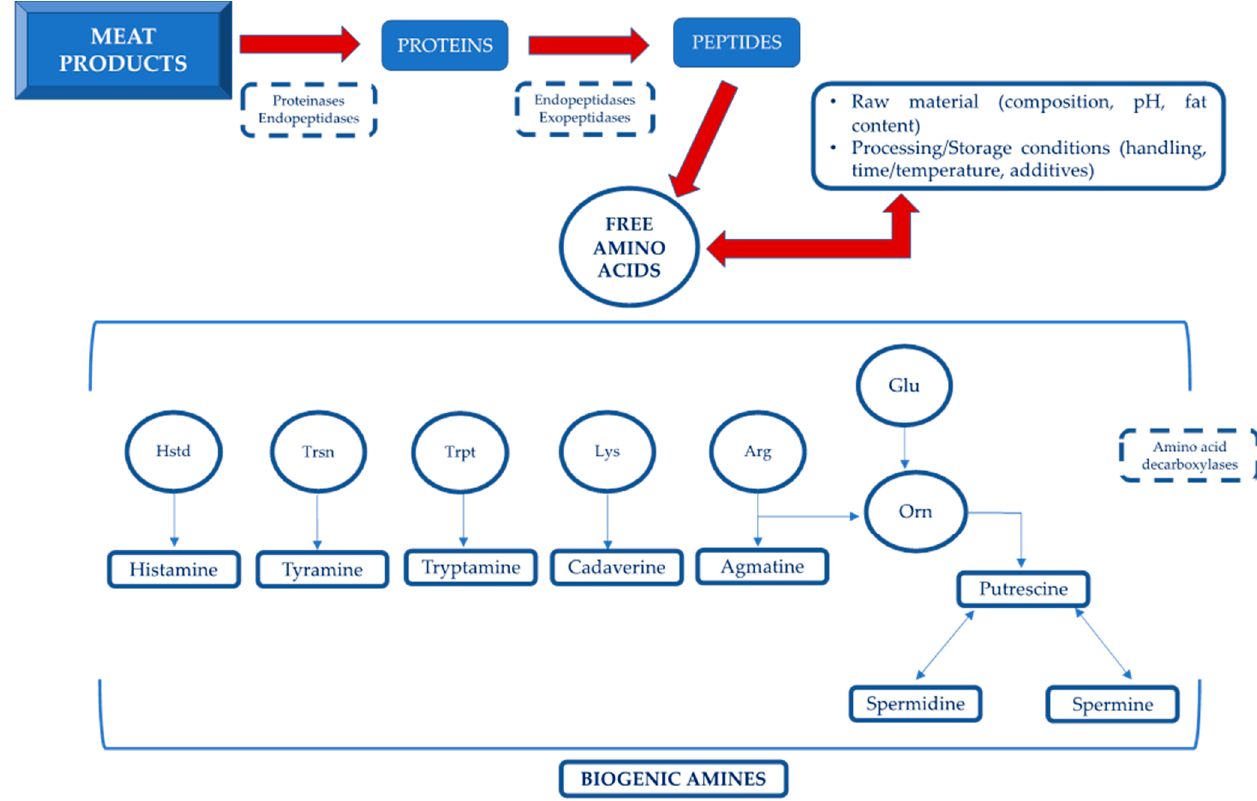
Figure 1. Scheme of biogenic amines formation. Legend: Hstd = Histidine; Trsn = Tyrosine; Trpt = Tryptophan; Lys = Lysine; Arg = Arginine; Glu = Glutamine; Orn = Ornithine.